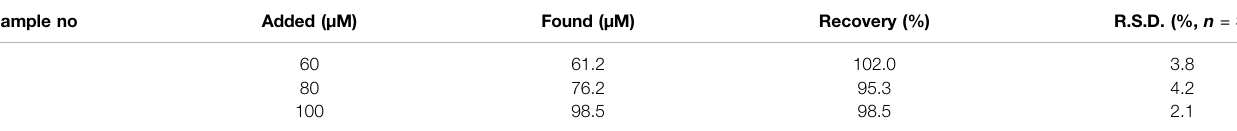
TABLE 2 | The testing result of different L-histidine concentrations in simulated human urine ( N (cid:1) 3). Sample